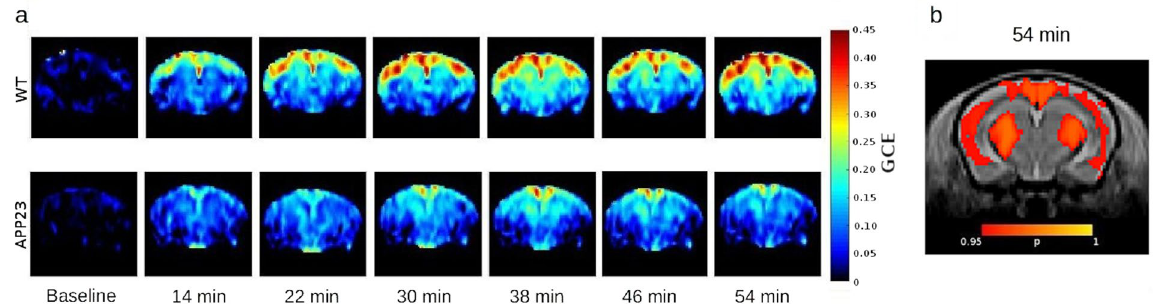
Figure 4. Graphic representation of the GCE ( a ) Time course represented as group mean images. Baseline is showed as the mean of the first three time points. ( b ) Voxel wise comparison. T-test on the normalized images representing the GCE 54 minutes after 2DG injection. In red the areas where WT > APP23 with p < 0.05.